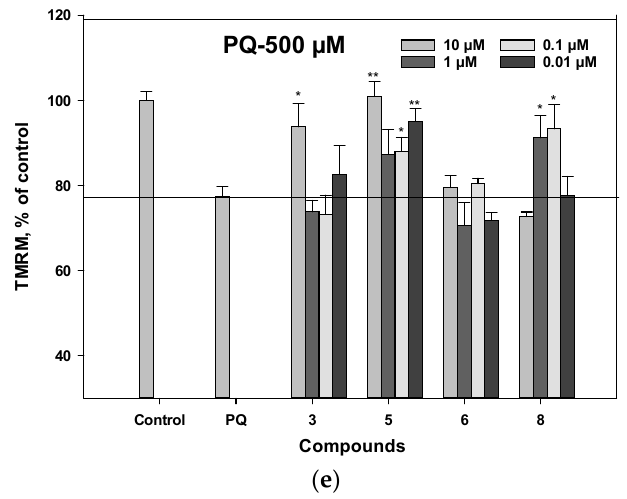
Figure 3. The influence of polyphenolic compounds from L. bicolor on cell viability ( a – c ), ROS levels ( d ), and mitochondrial membrane potential ( e ) in Neuro-2a cells treated with PQ (1 mM). The percentage of living cells treated with various compounds and PQ was measured by MTT assay. Each bar represents the mean ± SEM of three independent replicates. (*), (**), and (***) indicate, respectively, p < 0.05, p < 0.005, and p < 0.001 versus PQ-treated cells. The difference between control and PQ-treated cells was considered significant.